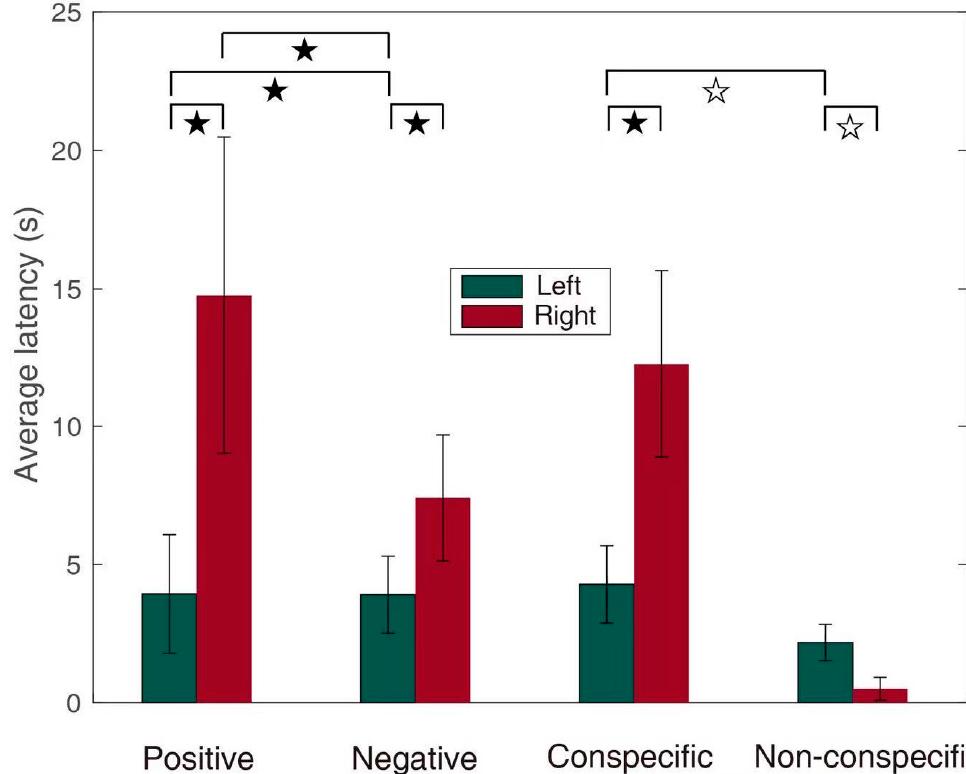
Figure 4. The latencies of head and ear orientation responses to different stimuli in giant pandas. The bars represent average response latencies (mean ± SEM). The stars represent the significance of latencies for the different stimuli ( ★ p < 0.05, ☆ p < 0.1).